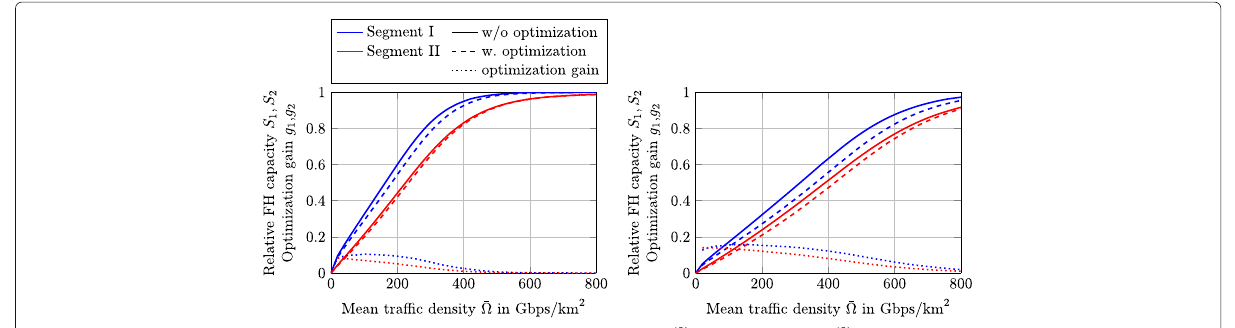
Fig. 11 Impact of pilot optimization. Relative FH capacity after optimization for K ( 0 ) max = 64 (left) and K ( 0 ) max = 128